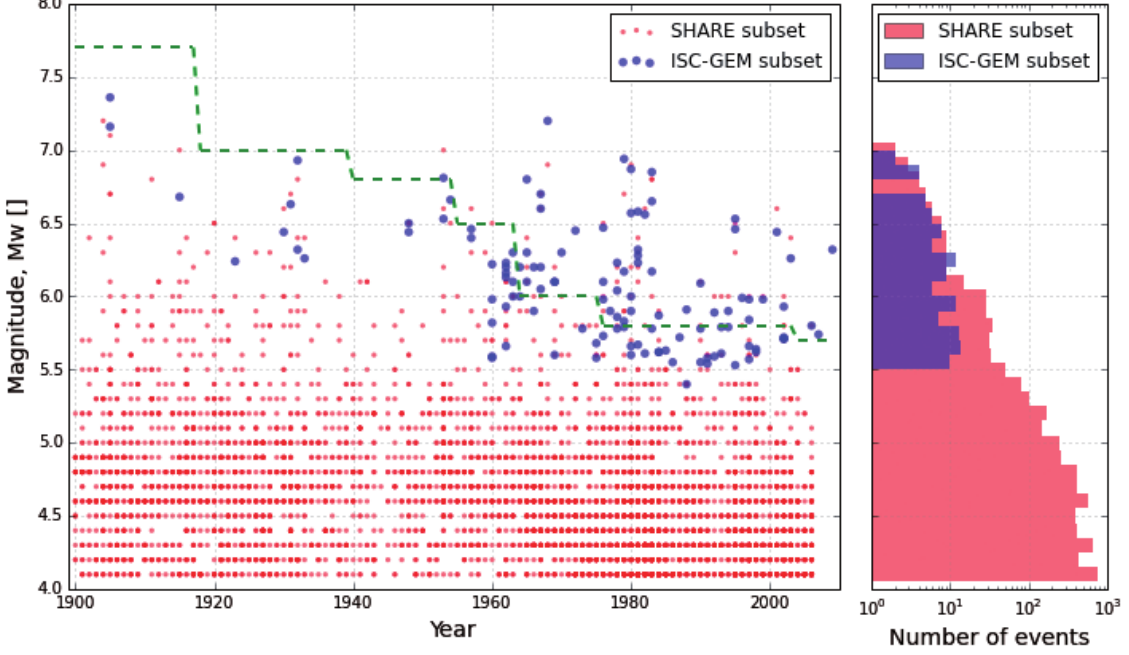
Figure 6. (Left panel) Time-Magnitude plot showing the earthquakes included in the ISC-GEM and SHARE catalogues. The earthquakes in this plot have magnitude larger than 4.0 and epicentral location included between longitude 0° and 25°E and latitude comprised between 38°N and 55°N. (Right panel) Histograms showing the distribution per magnitude bins (0.1 magnitude units width) of the two catalogues considered in this example. The green dashed line shows the completeness intervals proposed by Michael